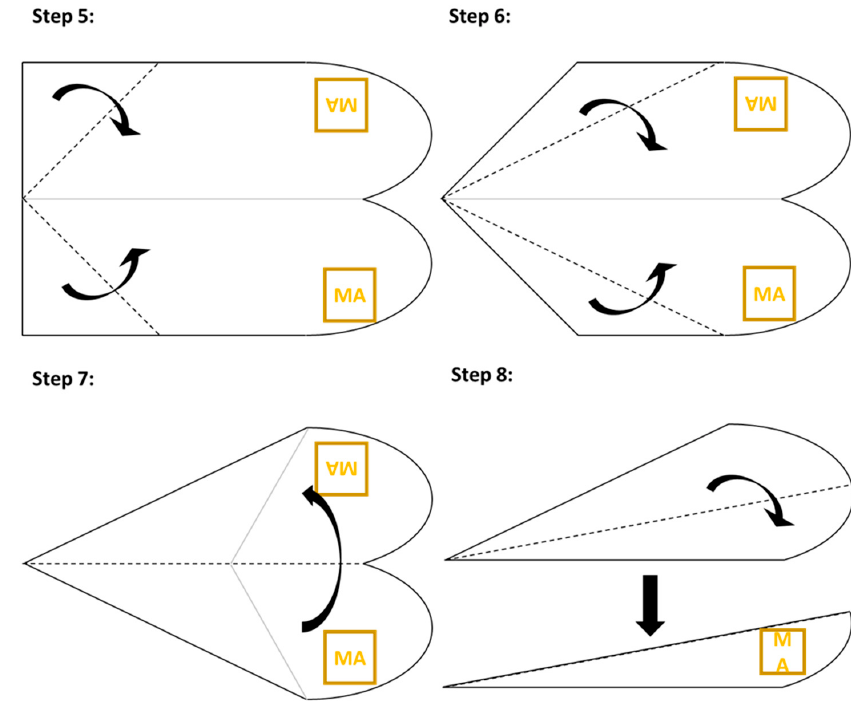
Figure 5. Paper plane drawing—Part 1.